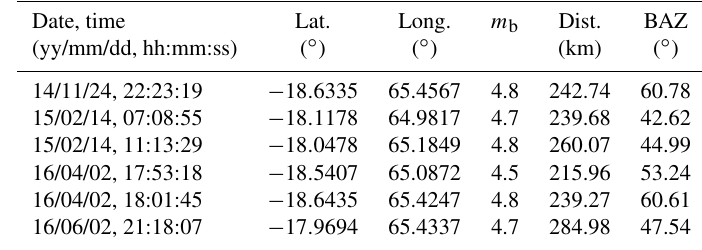
Table 2. Details of events from USGS catalogue for comparison.